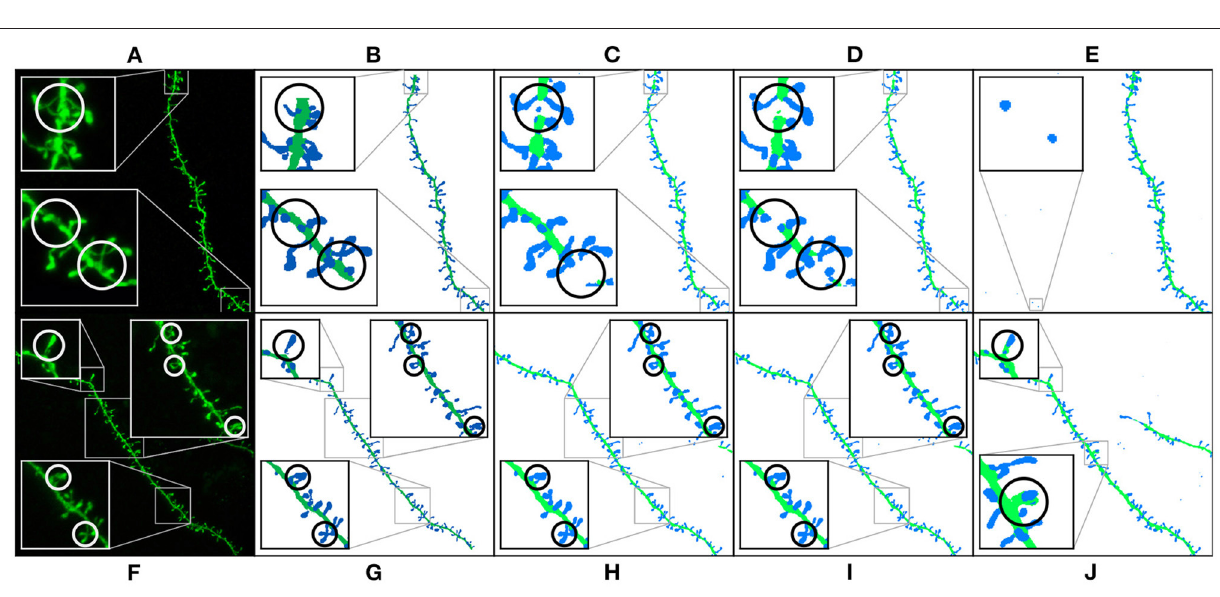
FIGURE 9 | Results of running M1, M2, and M3 models on two images of the test set: This figure shows the maximum projection of two confocal images (A,F) , the GT segmented images (B,G) , M1 results (C,H) , M2 results (D,I) , and M3 results (E,J) . The following issues are highlighted: unconnected components (C,D) , overlapping spines (H,J) , noise (E) , and misclassification (J) . We use dark colors to show the manual segmentation (GT) and bright colors for network predictions. The segmented spines are shown in blue and the dendritic shafts in